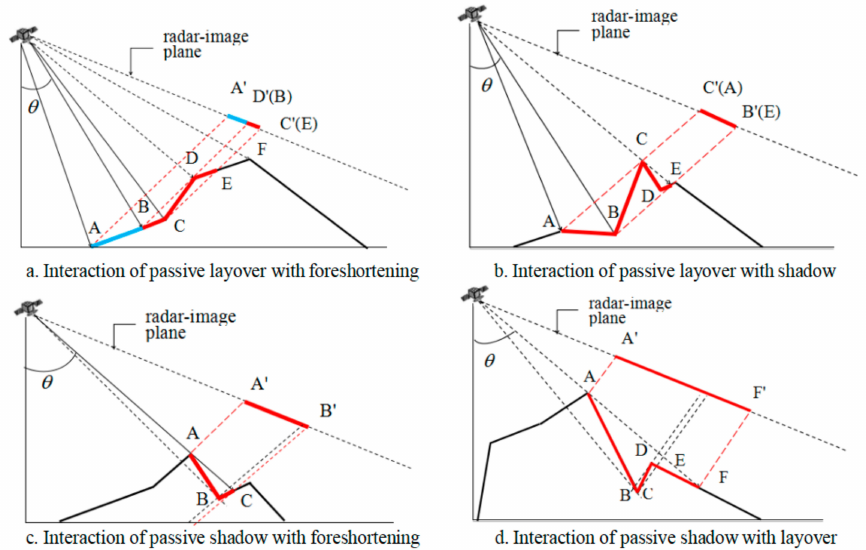
Figure 2. Interactions of the SGD.